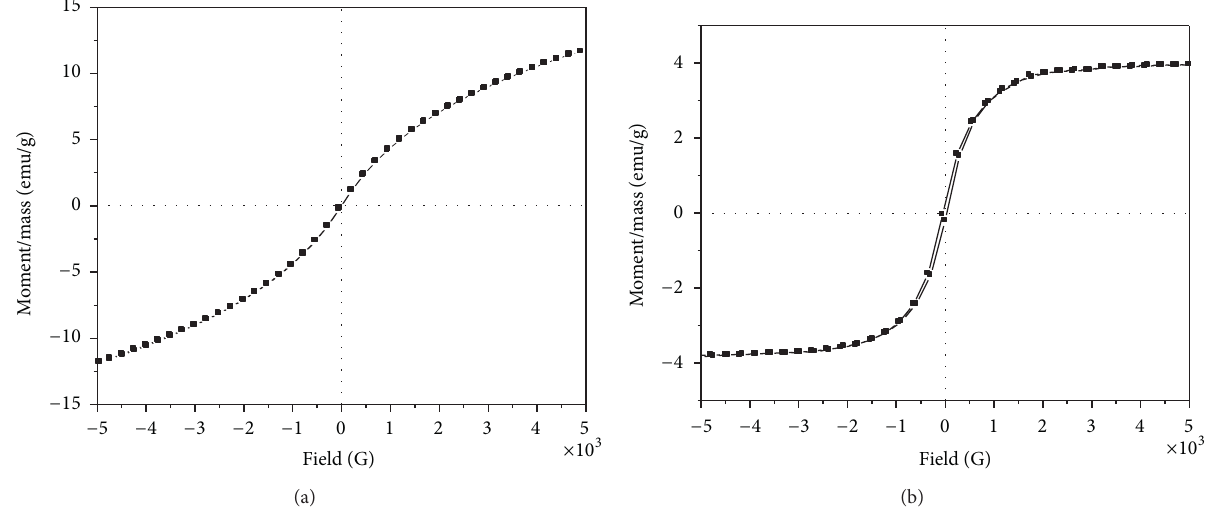
Figure 4: The hysteresis loops of (a) Fe 3 O 4 ferrite nanocrystals and (b) Fe 3 O 4 /PANI nanocomposites obtained from reverse microemulsion measured at 300